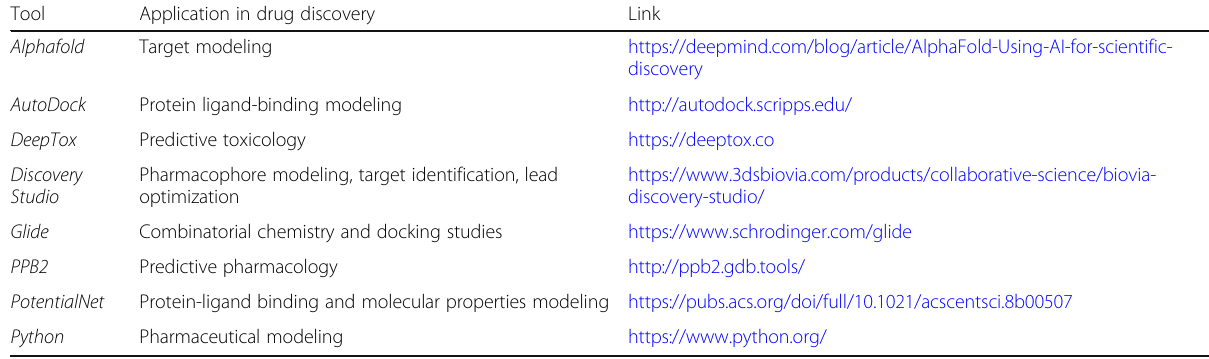
Table 3 Examples of pharmaceutical modeling and artificial intelligence-guided drug discovery tools